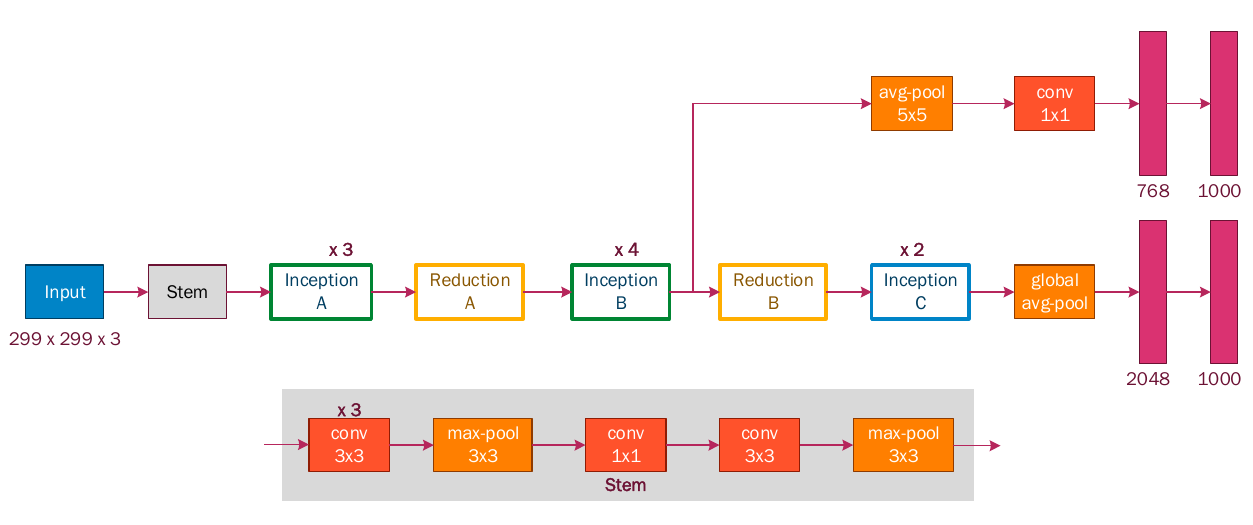
Figure 8. Inception-v3 architecture.